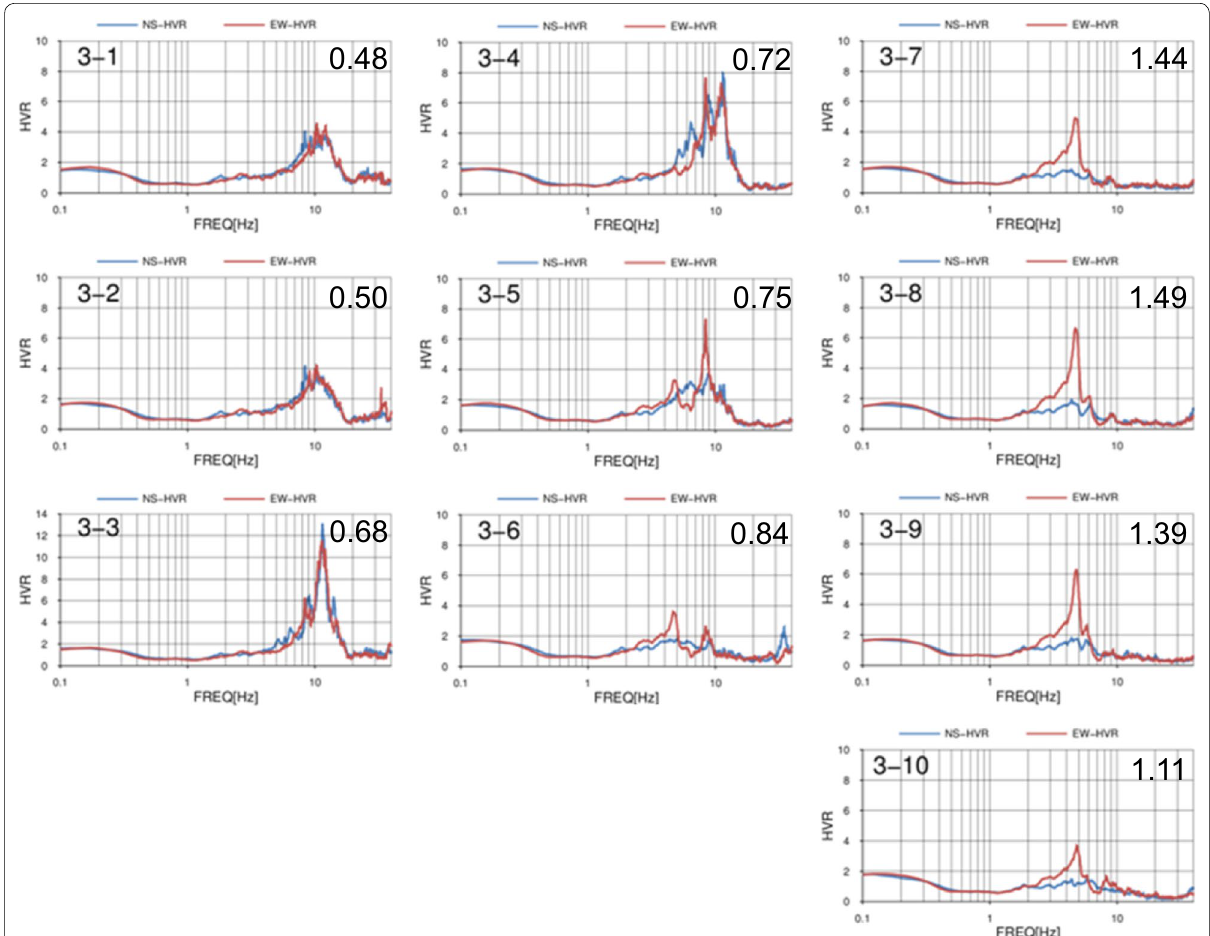
Fig. 4 Comparison of MHVRs along Line-3 shown in Fig. 2a. The figures from top-left to bottom-right are aligned from south to north on the survey line. Red and blue lines indicate NS/UD and EW/UD, respectively. The difference between the two is significant for points 3-7 to 3-9. The value of γ for each point is denoted in the right-top